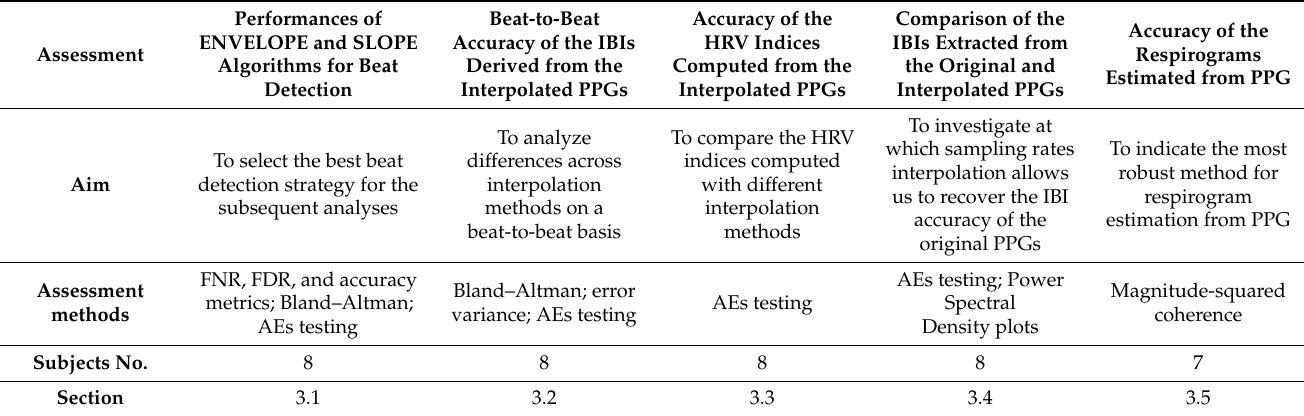
Table 1. Main statistical evaluations reported in the Results section. Each assessment was conducted for every sampling rate and protocol condition. The number of participants considered for each evaluation is